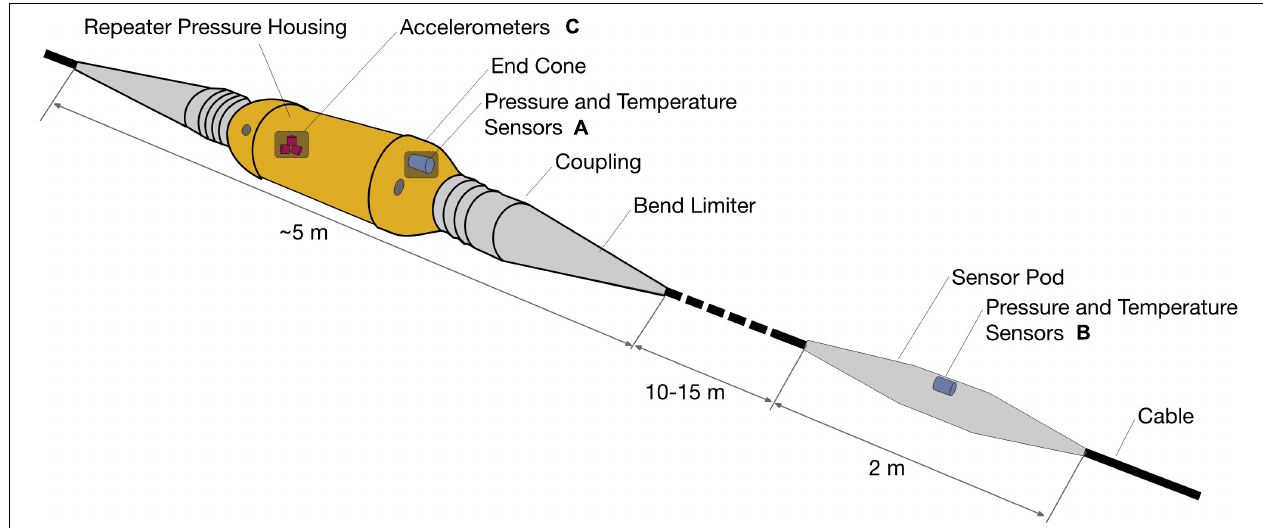
FIGURE 14 | Illustration of a repeater housing showing two possible sensor mounting locations: (A) on the end of repeater housing under the bell housing or (B) in an external pod. Accelerometers are mounted inside the pressure housing (C) . Permission obtained for use of